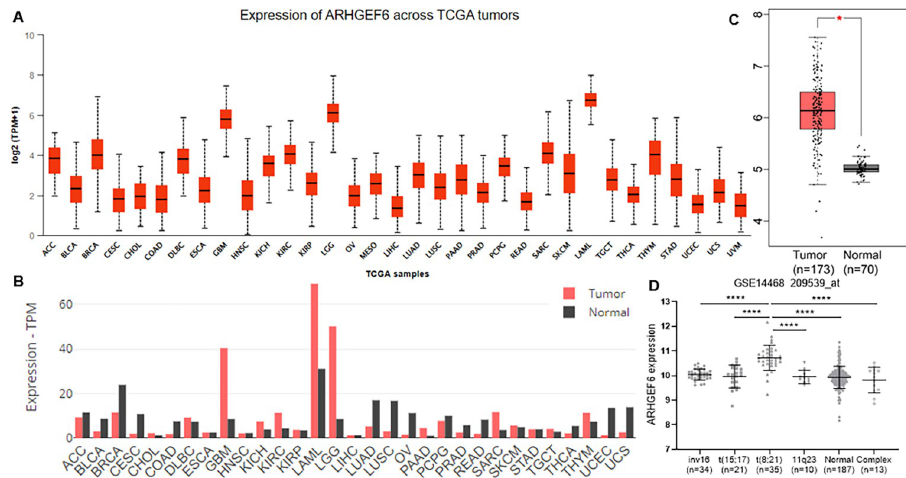
Fig 1. ARHGEF6 expression in AML. (A) ARHGEF6 expression in pan-cancer, result from UALCAN. (B) The expression of ARHGEF6 in different cancerous and normal tissues using the GEPIA. Bar height refers to the value of the median expression. (C) ARHGEF6 expression between AML and normal samples, result was obtained by GEPIA analysis. * , p < 0.05. (D) ARHGEF6 expression in AML among various karyotypes, according to GSE14468 in the GEO database. **** , p <